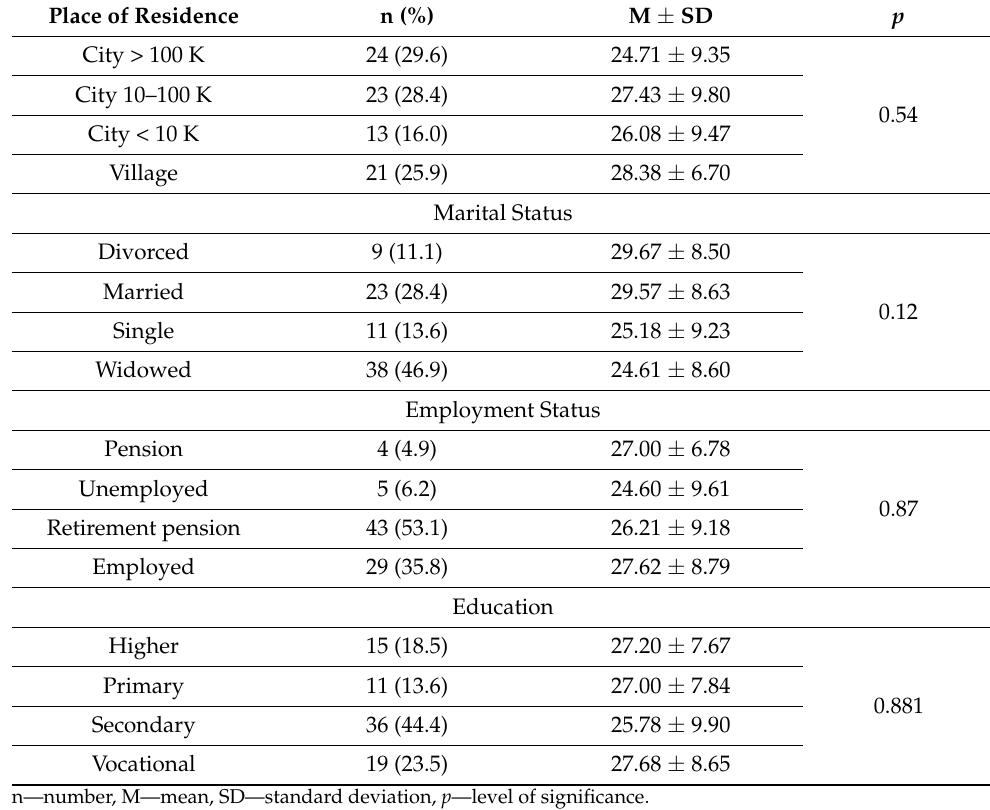
Table 5. Sociodemographic variables and level of disease acceptance.